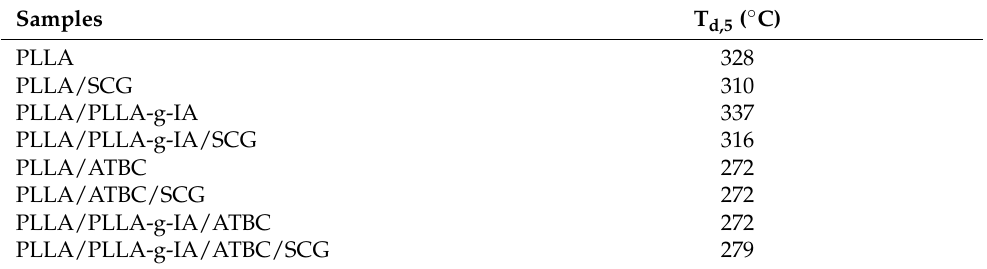
Table 6. Thermodegradation temperatures.